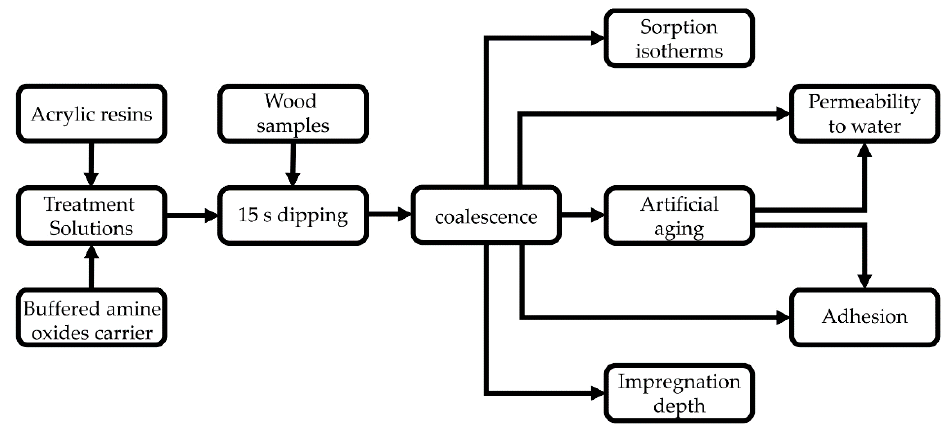
Figure 1. Experimental procedure of the study. Table 3. Proportion (in %) of the different chemicals in the treatments